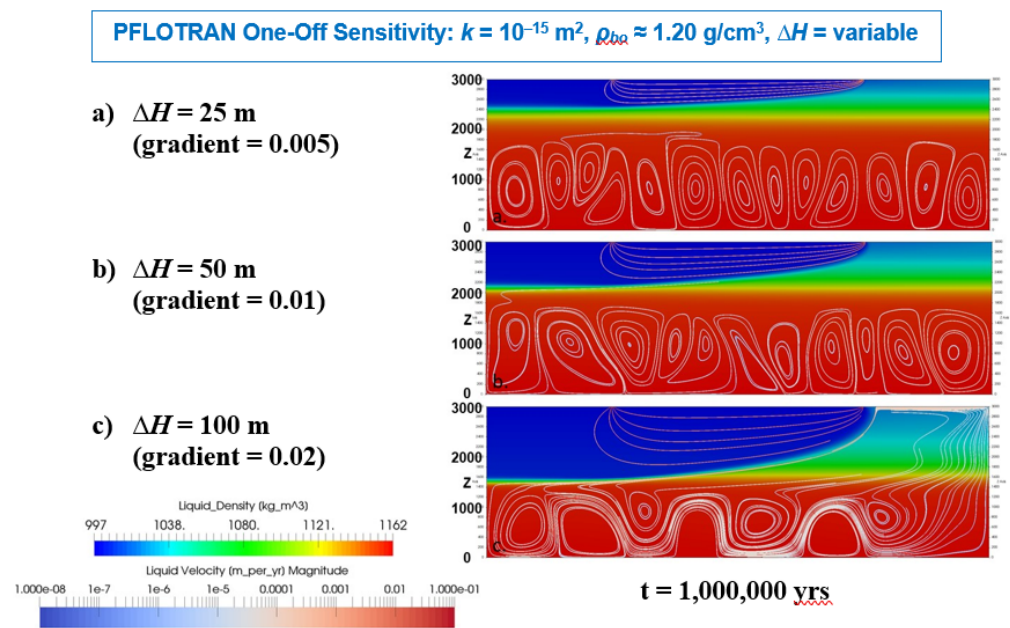
Figure 6. PFLOTRAN (k = 10 − 15 m 2 ) Model Results (Sensitivity to Hydraulic Head Difference) as a function of hydraulic gradient; ( a ) 0.005, ( b ) 0.01, ( c ) 0.02.